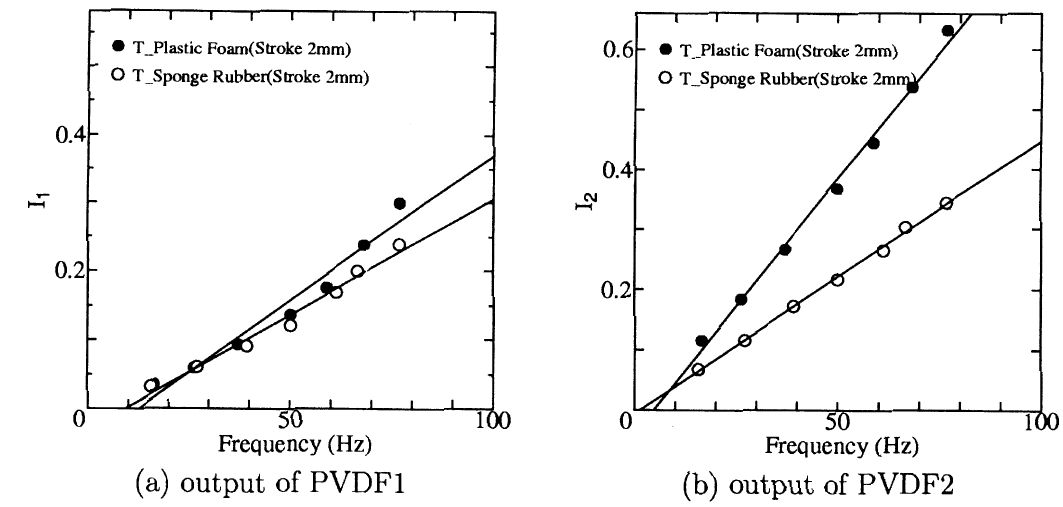
Fig. 6. Frequency responses of PVDF1 ( I 1 ) and PVDF2 ( I 2 ) on triangular objects of plastic foam and sponge rubber.